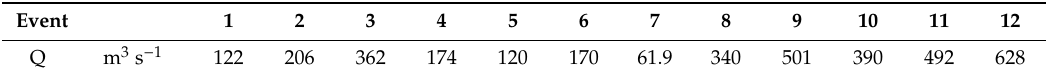
Discharge (Q) scenarios (events) for the Thur River catchment in Canton of Thurgau, Switzerland.